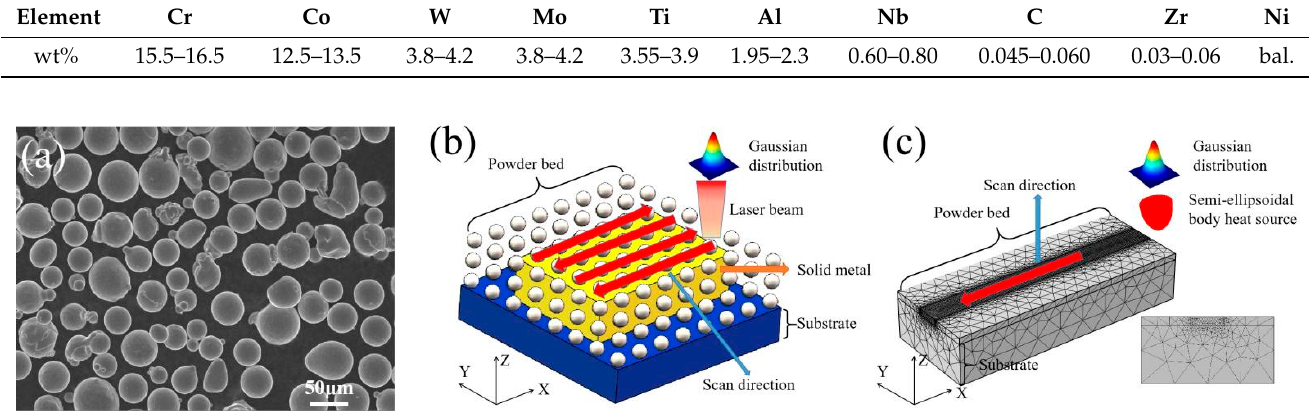
Figure 1. ( a ) SEM image of FGH96 powders; ( b ) Schematic diagram of selective laser melting; ( c ) Construction of the 3D finite element model. Table 2. The used processing parameters in this